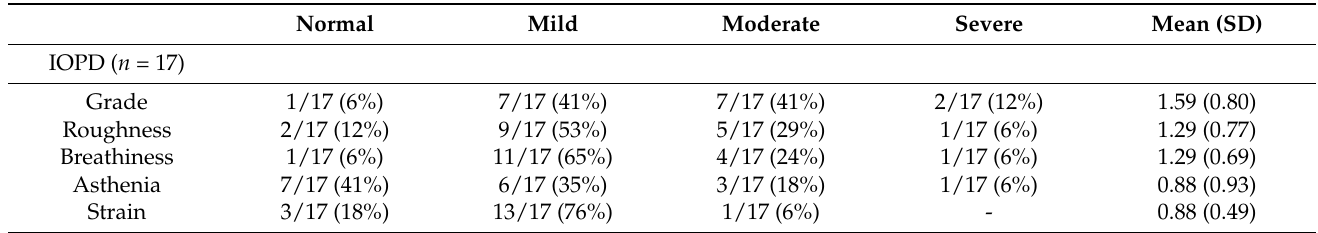
Table 3. Auditory-perceptual ratings of vocal